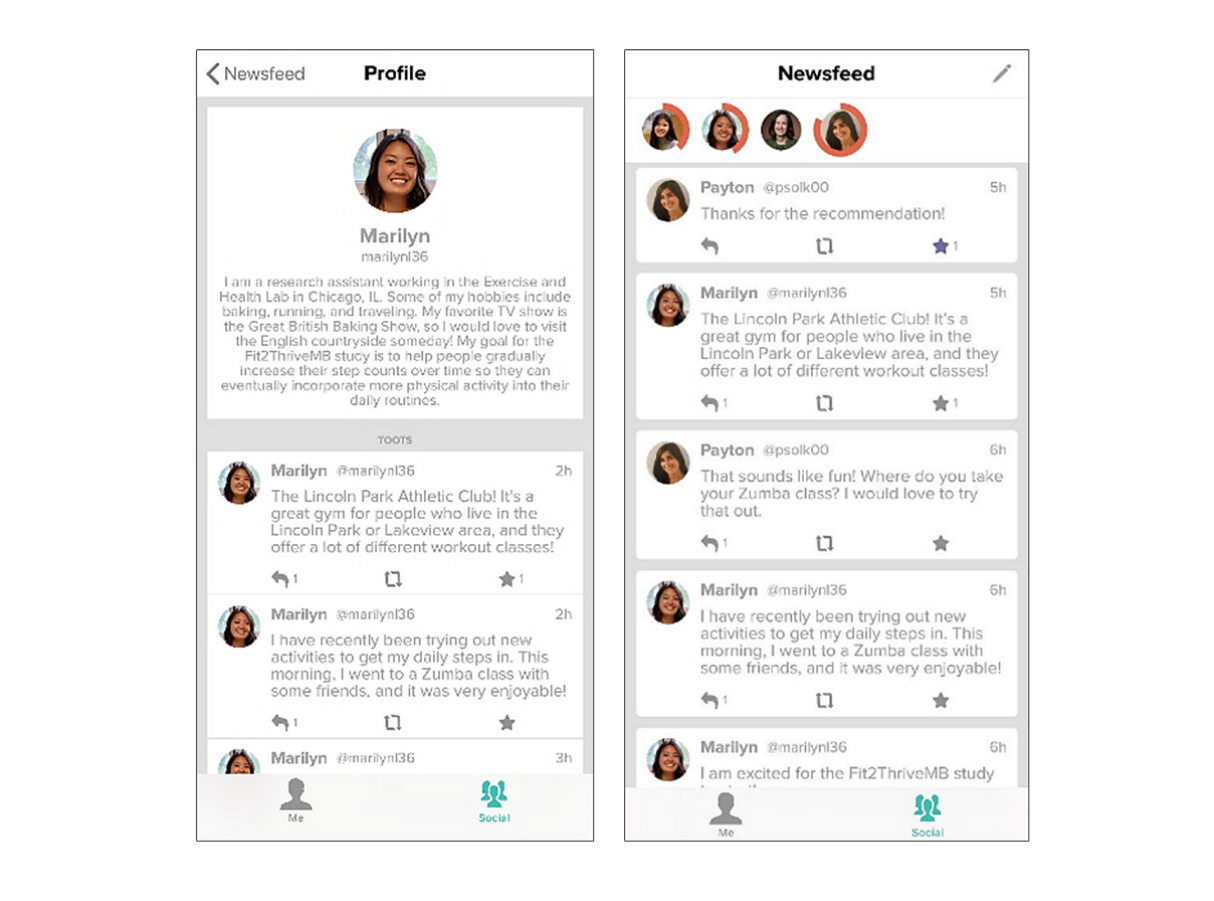
Figure 5. Fit2ThriveMB app social feed